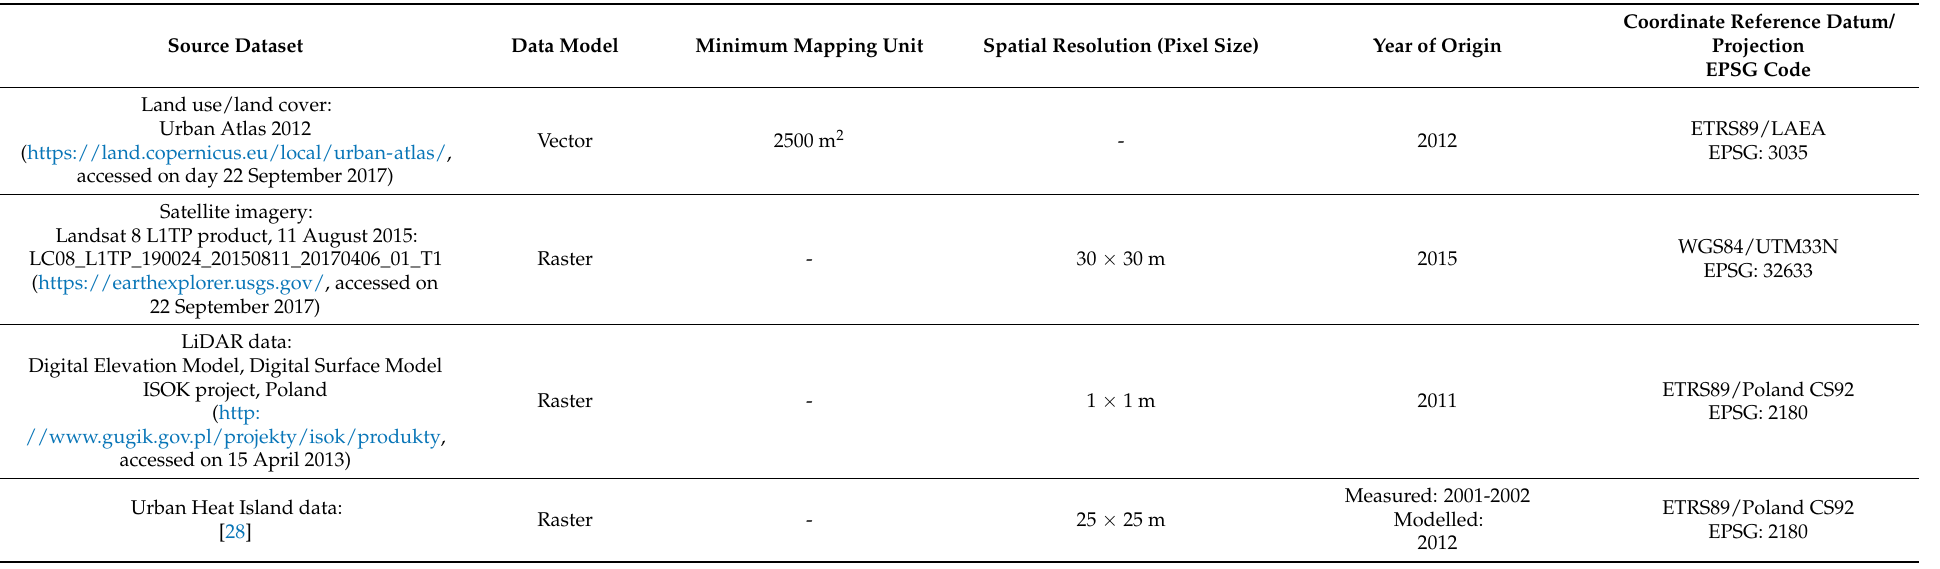
Table 1. Geographic data used in the study.